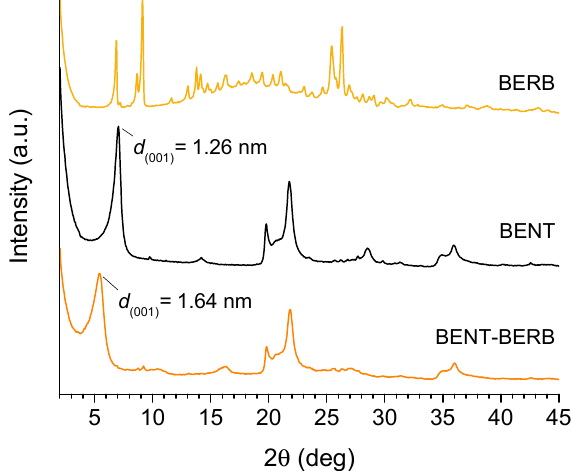
Figure 1. XRD analyses. X-ray diffraction patterns of berberine (BERB), bentonite (BENT) and bentonite–berberine composite (BENT-BERB).